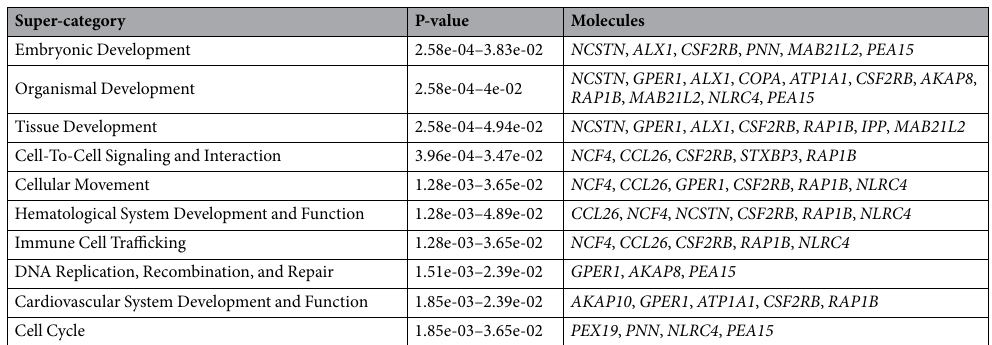
Table 2. Top-ten enriched super-categories from disease and functional enrichment analyses using IPA software, considering 40 genes identified in the gene-wide analyses surpassing follow-up significance threshold (P-value <